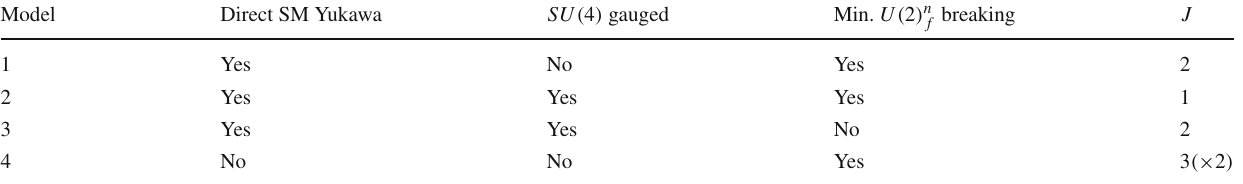
Table 1 Main features of the four simplified models considered Model Direct SM